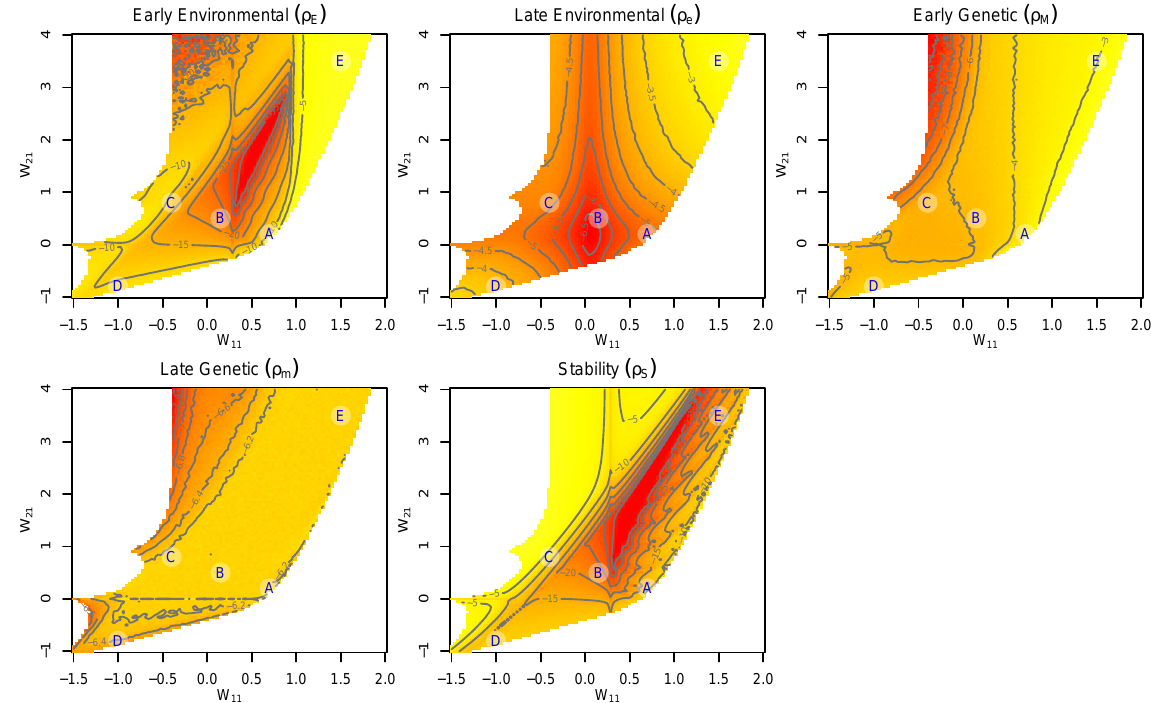
Figure 2 – Robustness indicators ( ρ E , ρ e , ρ M , ρ m , and ρ S ) estimated for an exhaustive con- tinuum of two-gene networks with an arbitrary expression equilibrium at P Although two-gene networks have four independent genetic parameters, only two were represented here, the two others being computed to ensure the desired equilibrium. Red stands for the maximum robustness (lowest robustness scores); yellow for minimum ro- bustness (highest scores). For readability, color scales are different across panels.